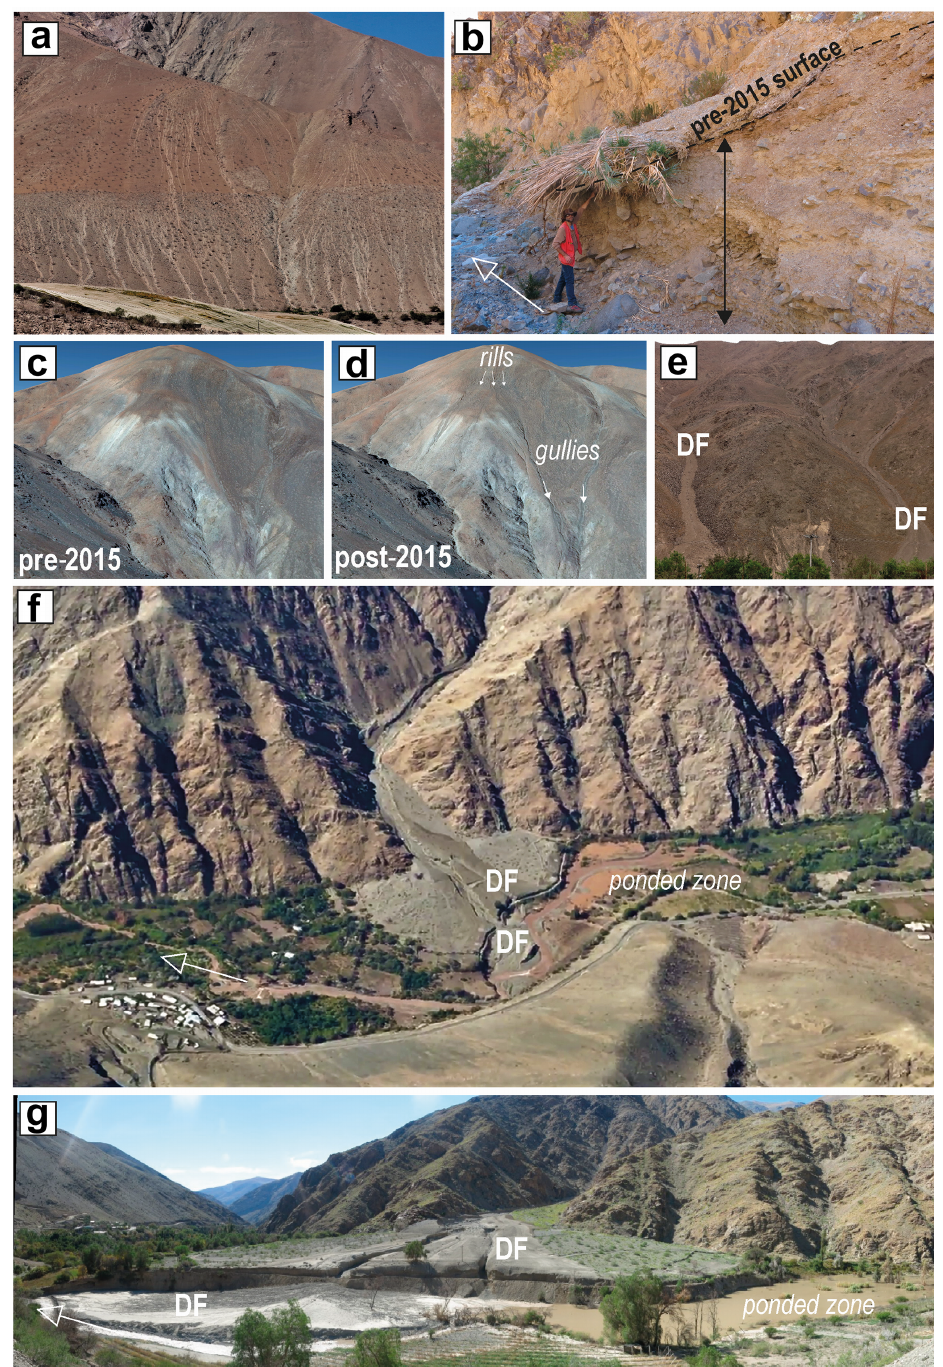
Figure 3. (a) Field evidence of high-density rill formation during the March 2015 storm on hillslopes of the Huasco River valley. (b) Example of a deeply incised alluvial channel within a tributary catchment. Dashed line indicates pre-March 2015 storm surface with covered vegetation lying down overlain by a 30cm layer of debris flow (DF) deposits triggered by the storm inland subsequently incised by more diluted flows. The person for scale is 180cm tall. White arrow indicates the flow direction downwards. Panels (c) and (d) indicate pre- and postlandscape configuration showing rills, gullies and debris flows. (e) Debris flows (DF) with lateral levees deposited within the tributary catchment alluvial channels with subsequent incision. (f) Oblique aerial view of debris flow deposits on a tributary junction alluvial fan and the upstream zone which was ponded by the damming with the distal depositional lobe. (g) Front view of the tributary junction alluvial fan of (f)